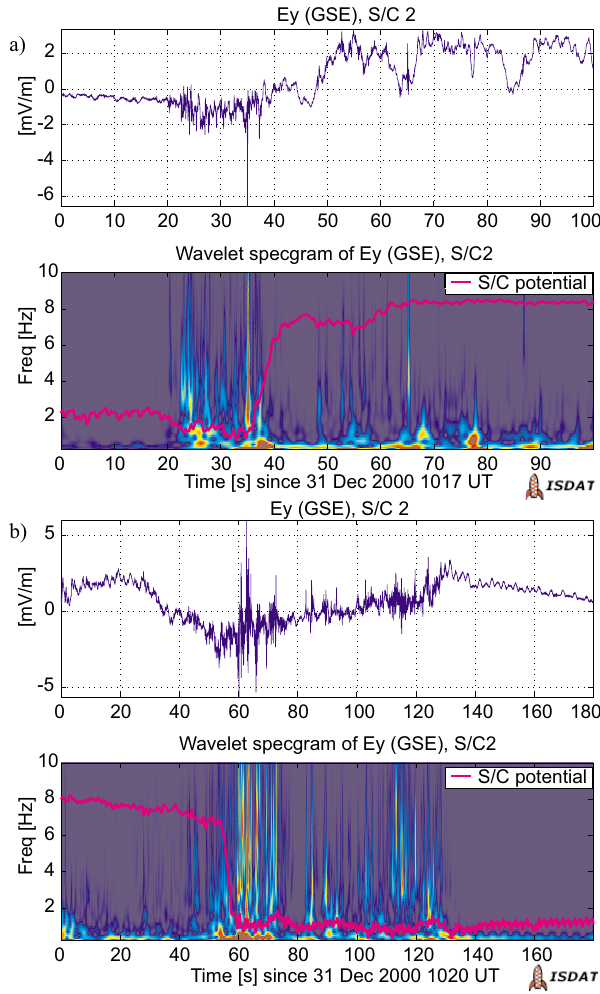
Fig. 6. (a) E y component of the electric field from satellite 2 (upper panel) and a wavelet transform of this signal (lower panel), using a linear color scale, for the boundary crossing leaving the magneto- sphere. The potential v ps is indicated, see also panel a of Fig. 3, (b) similar to a, but for the boundary crossing entering the magne-